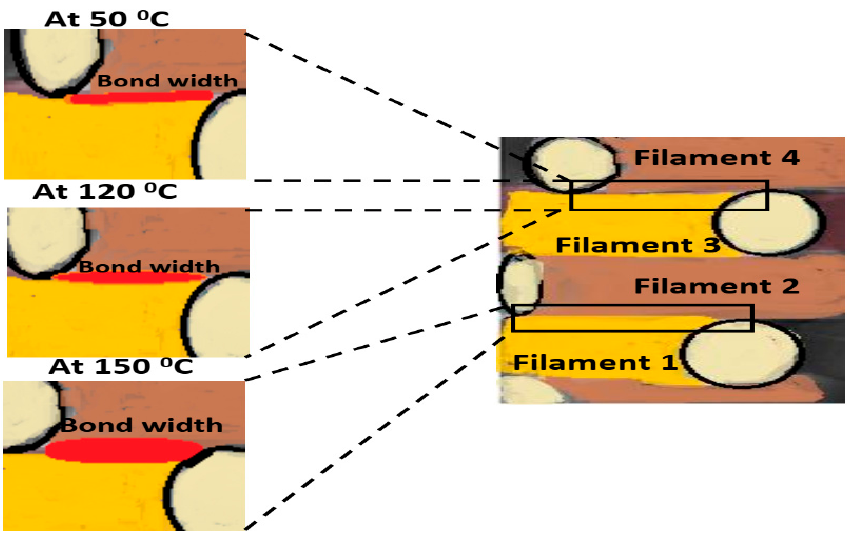
Figure 12. Effect of heat treatment temperature on the contacting surface of the filaments.